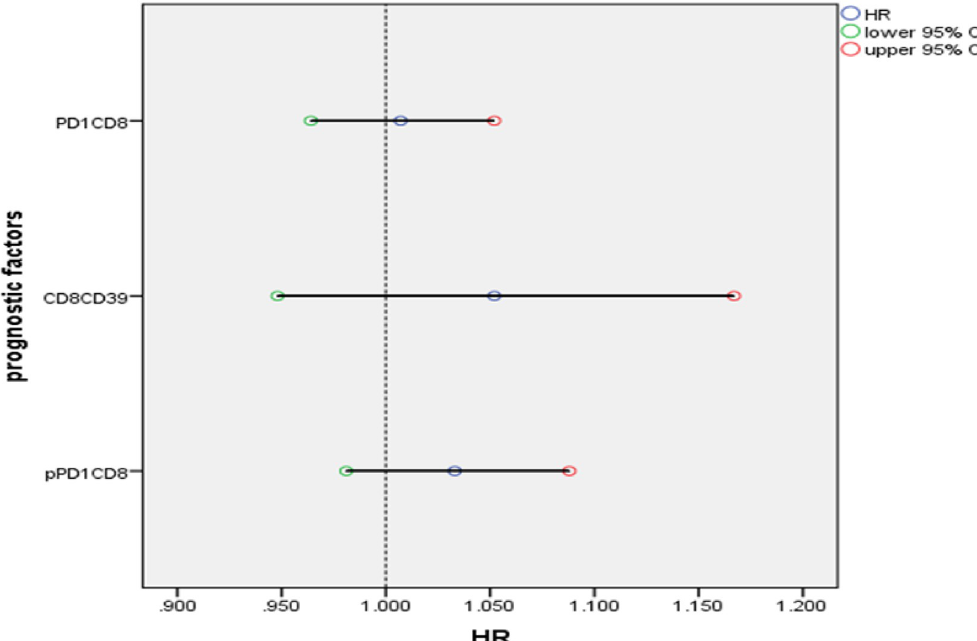
Fig 7. Forest plot of HR for different lymphocyte